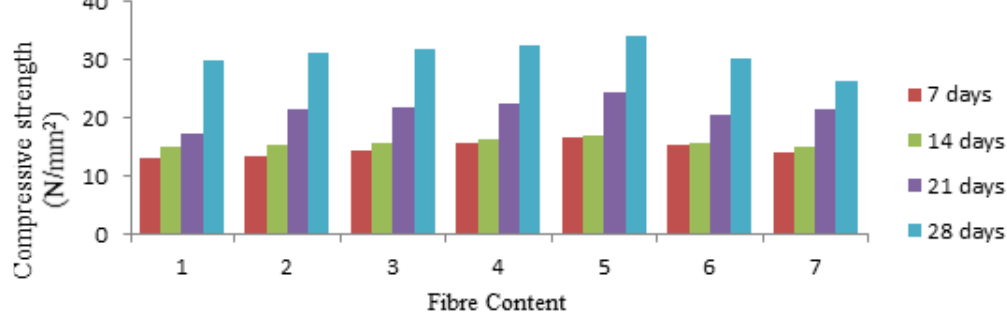
Figure 4. Variation of sisal fibre content with respect to compressive strength and